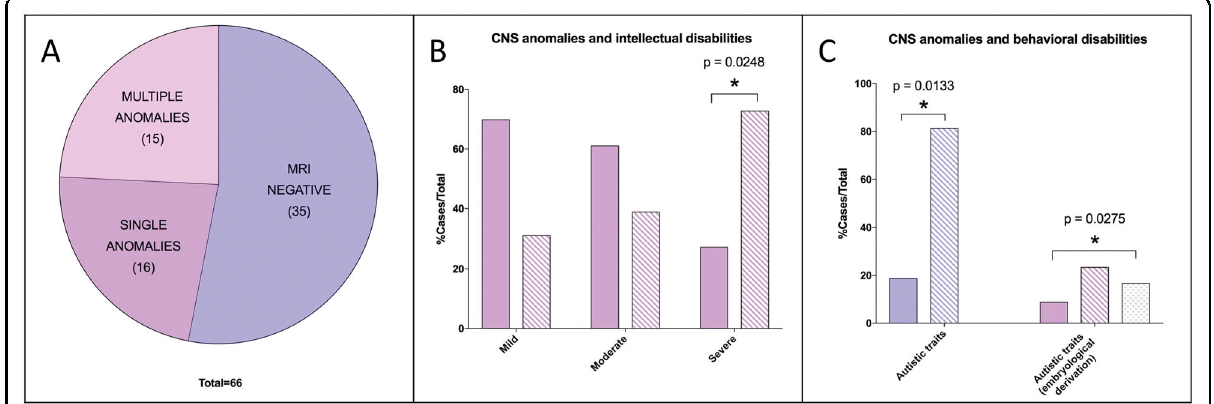
Fig. 1 CdLS brain abnormalities in hindbrain-derived structures correlate with cognitive and behavioral alterations. A MRI data distribution in the cohort of CdLS patients. Purple: MRI negative (35/66); mauve: MRI positive — single anomalies (16/66); pink: MRI positive — multiple anomalies (15/66). B CNS anomalies and intellectual disabilities. Solid mauve: MRI negative; striped mauve: MRI anomalies. C CNS anomalies and behavioral disabilities — autistic traits. Solid purple: MRI negative; striped purple: MRI anomalies; solid mauve: MRI negative; striped mauve: Rhombencephalon derivation; dotted mauve: Prosencephalon derivation. * p < 0.05; * vs MRI